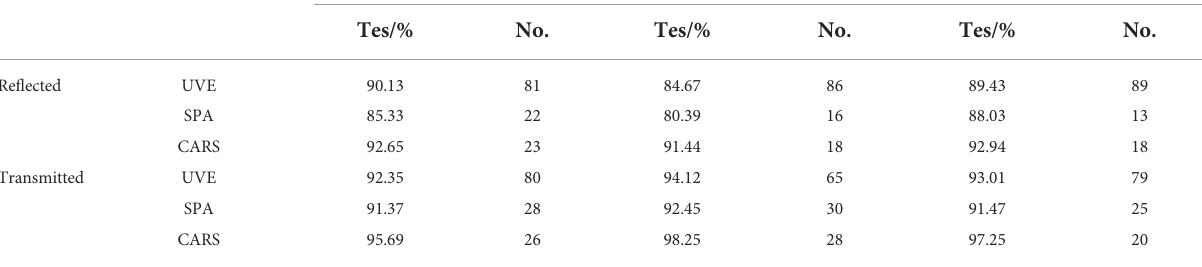
TABLE 2 The classi fi cation results of hybrids and female parent seeds based on different characteristics selection spectra. Group